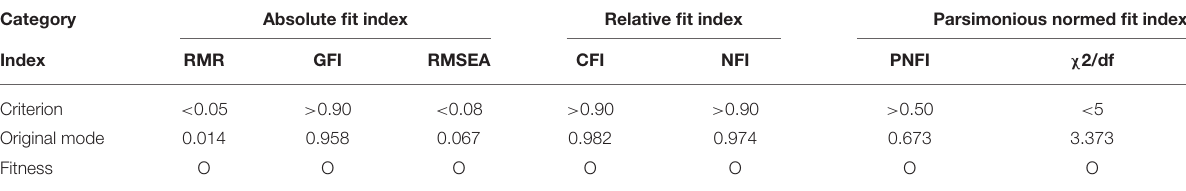
TABLE 3 | Analysis of the suitability.